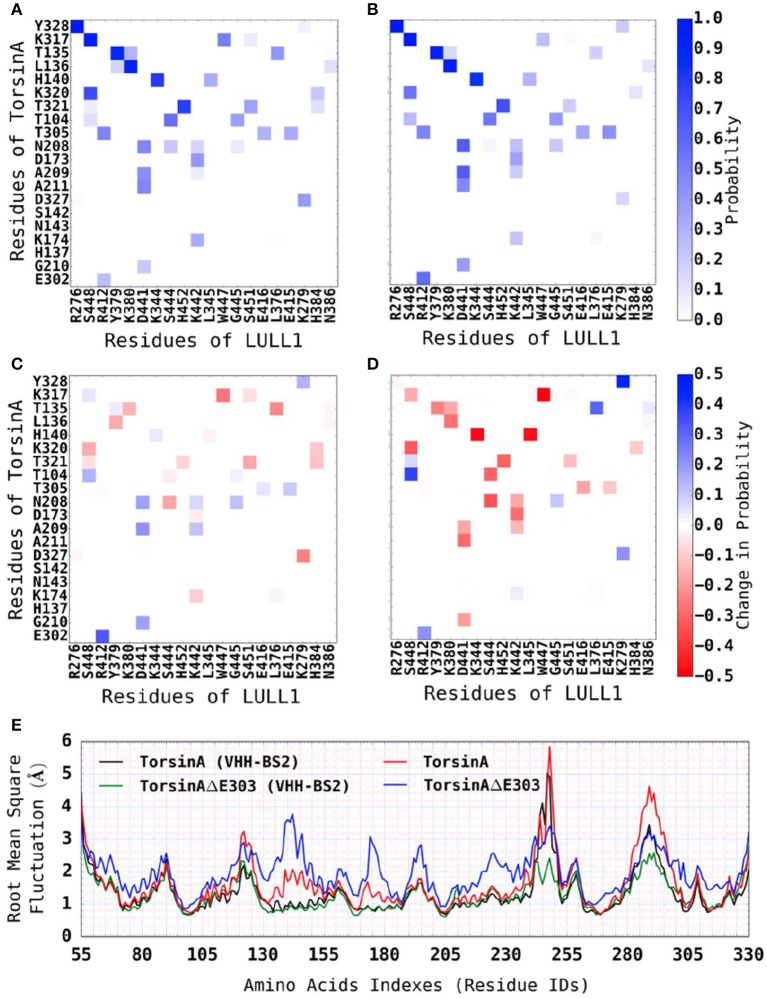
Reduced differences between TorsinA-LULL1 interactions and TorsinAΔE303-LULL1 interactions in the presence of VHH-BS2 nanobody. We show the most active residues (A) in TorsinA-LULL1 interactions and (B) in TorsinAΔE303-LULL1 interactions, and (C) the reduced interactions (i.e., B-A) due to ΔE303. (D) Shows similar information as C, but for the TorsinA-/TorsinAΔE303-LULL1 system without VHH-BS2. Additional pieces of evidence that the crystallization conditions (e.g., the presence of VHH-BS2) reduce the difference between TorsinA and TorsinAΔE303 is shown in (E) wherein the differences in the RMSF between the amino acids of TorsinA and the amino acids of TorsinAΔE303 is attenuated by the presence of VHH-BS2. The E303 deletion from TorsinA (thus TorsinAΔE303) significantly and persistently reduces TorsinAΔE303-LULL1 interactions compared to TorsinA-LULL1, but the effect of the mutation is attenuated by the crystallization environment/conditions (such as the presence of VHH-BS2). A comparison of (C,D) shows (by the fainter shades of blue and red in the current (C), but the darker shades in D) that the environment/conditions wherein the X-ray structures for TorsinA-LULL1 and TorsinAΔE303-LULL1 were solved (such as the presence of VHH-BS2) attenuated the differences between TorsinA-LULL1 interactions and TorsinAΔE303-LULL1 interactions.